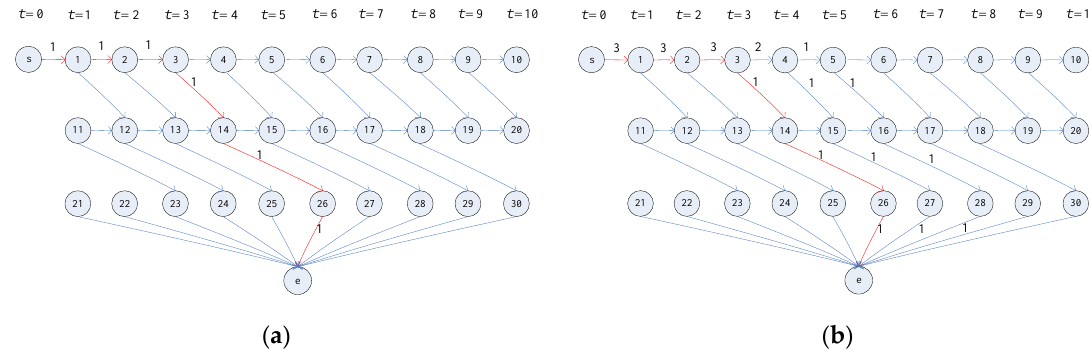
Figure 6. ( a ) The rerouted flows due to resource failure represented in RSTN 1 ( V 1 , A 1 ) ; ( b ) One solution represented in STN 1 ( V 1 , A 1 ) obtained after resource failure.